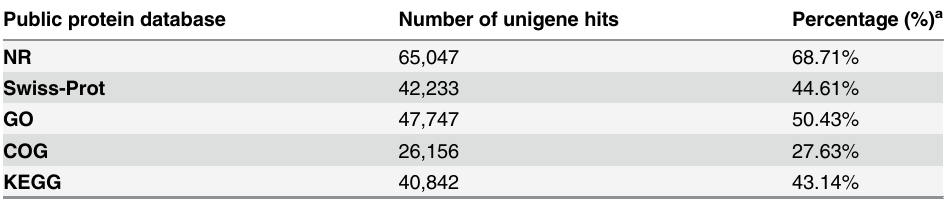
Table 2. A summary of the functional annotations of the assembled